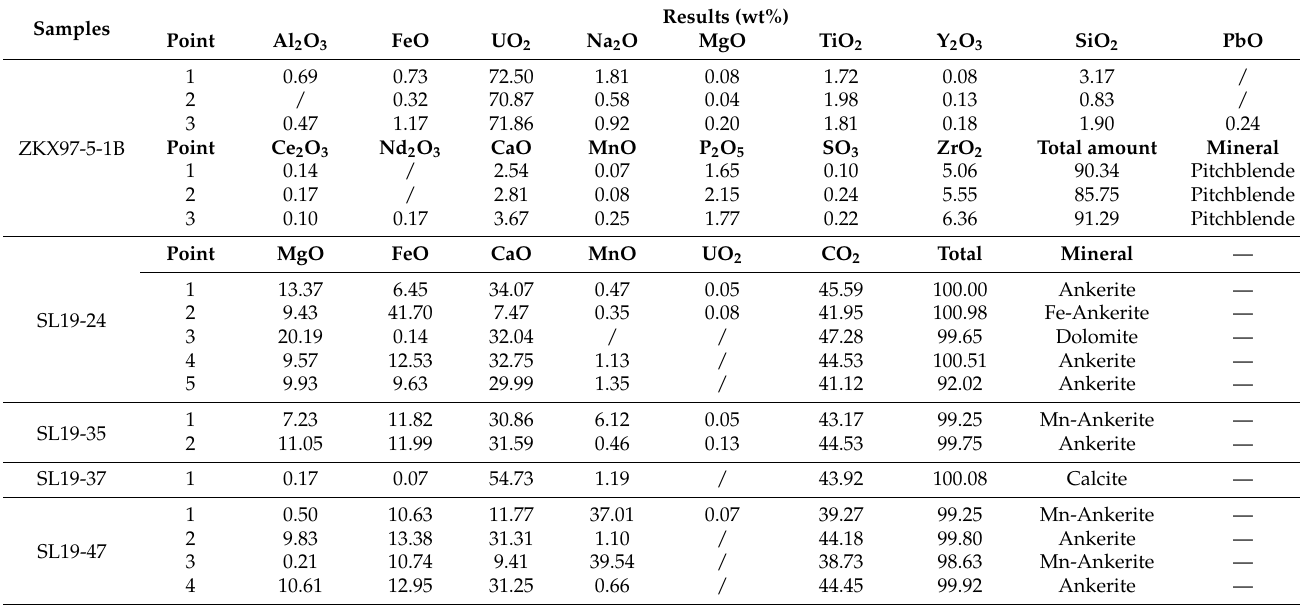
Table 1. EPMA data of carbonate minerals and pitchblende of the altered sandstone in the lower member of Yaojia Formation.